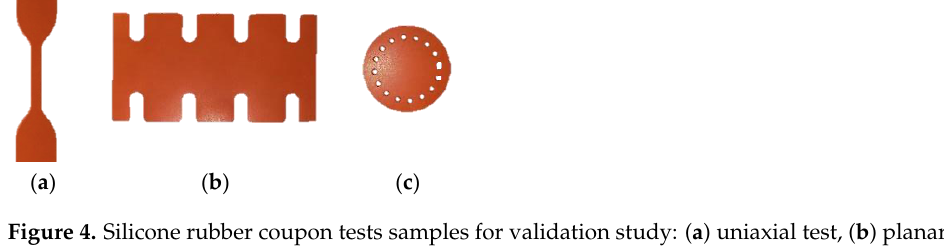
Figure 6. Experimental setups of O-ring multi-contact test for validation. 2.2.2. Experimental Coupon Testing for The Validation Study Rubbers exhibit a hyperelastic response to an applied deformation; their behavior can be modeled using their energy density function. Many numerical models have been defined previously, requiring the determination of their material parameters, which is feasible by performing experimental tests. Rubbers ’ response must be tested under vari- ous deformation directions; hence, uniaxial, planar, and equibiaxial tests are usually re- quired. The curve fitting procedure is followed to determine the materials parameters of the selected hyperelastic model. The material parameters defined by the procedure men- tioned above can be used as an input for FEA, which is considered a “ traditional ap- proach ” to simulating rubbers ’ behavior. In our study, uniaxial, planar, and equibiaxial coupon tests were carried out at a quasi-static loading rate with a crosshead moving at 1 mm/s with a sampling rate of 1 Hz at room temperature using a universal MTS Criterion 43 machine. An MTS LX500 laser extensometer was used to measure strain during the tests. A 500 N load cell was used for all tests except equibiaxial coupon tests. Since equibiaxial coupon tests require more than a 500 N load cell, a 10,000 N load cell was used for equibiaxial coupon tests. All experi- ments were repeated three times to ensure consistency. The experimental coupon testing setups are shown in Figure 7. ( a ) ( c ) Figure 7. Experimental coupon testing setup: ( a ) uniaxial test, ( b ) planar test, and ( c ) equibiaxial test.